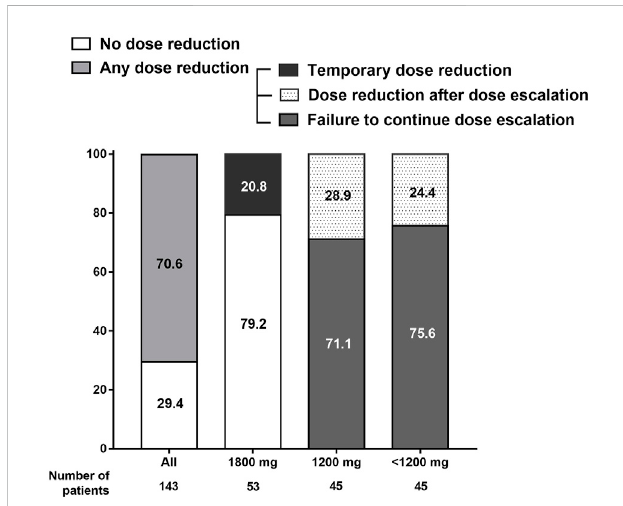
FIGURE 2 Adjustment of pirfenidone dose during the treatment course. Overall, 70.6% of the study participants experienced dose reduction at least once during the study period.